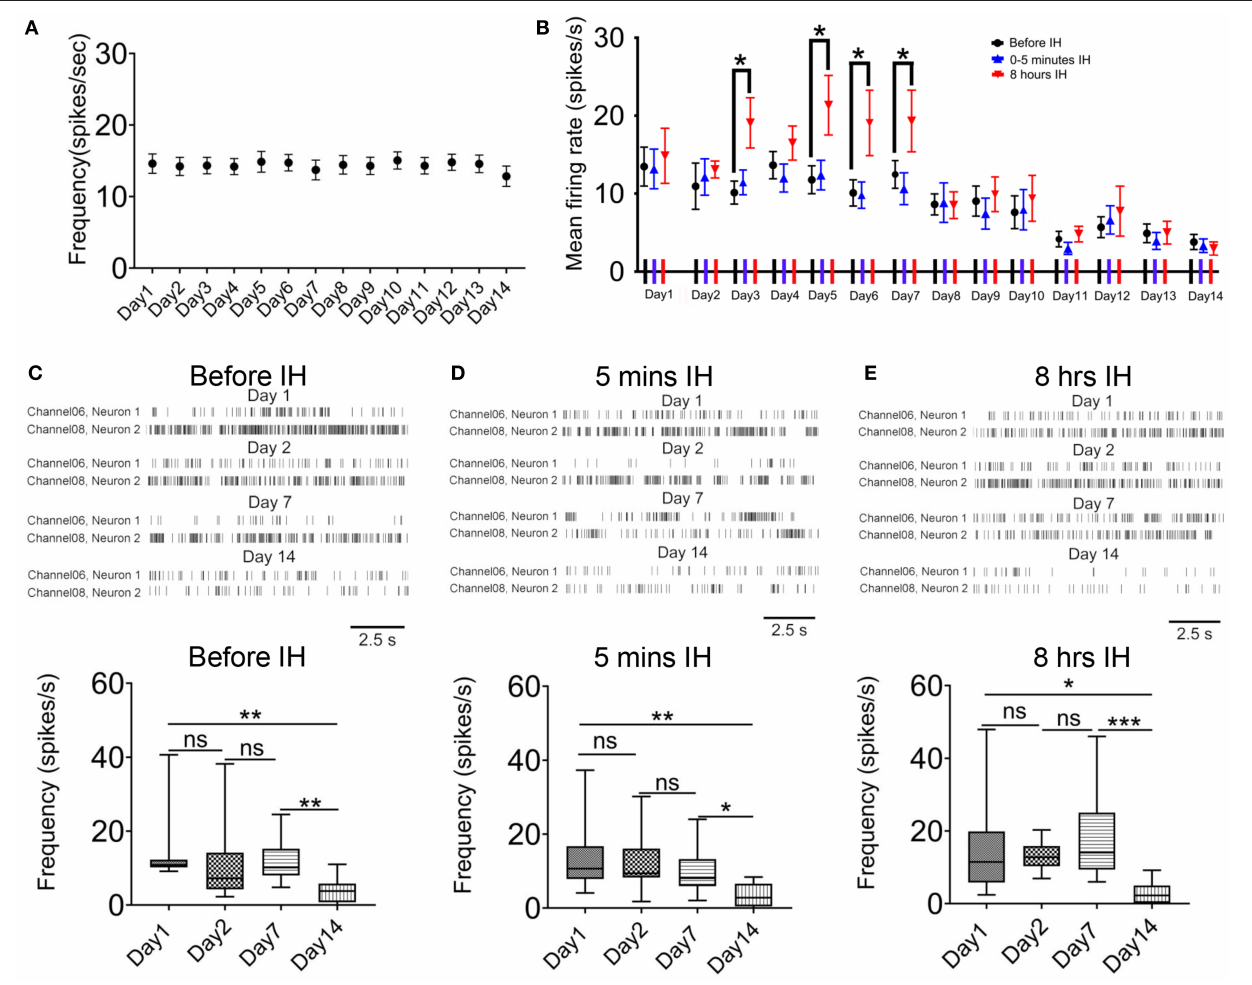
FIGURE 3 | Acute and long-term effects of intermittent hypoxia (IH) on the firing of CA1 putative interneurons. (A) Repeated measured ANOVA revealed that neuronal firing was not significantly affected in control group. (B) Summary of the mean firing rates of putative interneurons recorded in the three recording sessions in each day over the 2-week period. Apart from the significantly elevated firing of the putative interneurons after 8h of IH treatment in some days of the first week, the major effect of the chronic intermittent hypoxia was a strong suppression of firing found in the second week of IH treatment. (C) The up panel shows typical raster plots of the putative interneurons recorded before IH on day 1, 2, 7 and 14. Statistical results are shown on the bottom. (D) Typical raster plots of the putative interneurons recorded in the first 5 IH min of IH treatment on day 1, 2, 7 and 14 are shown on the up and the mean data are summarized on the bottom. (E) Typical raster plots of the putative interneurons recorded in the last 5 IH mins of IH treatment on day 1, 2, 7 and 14 are shown on the up and the mean data are summarized on the bottom. * P < 0.05, ** P < 0.01, *** P <